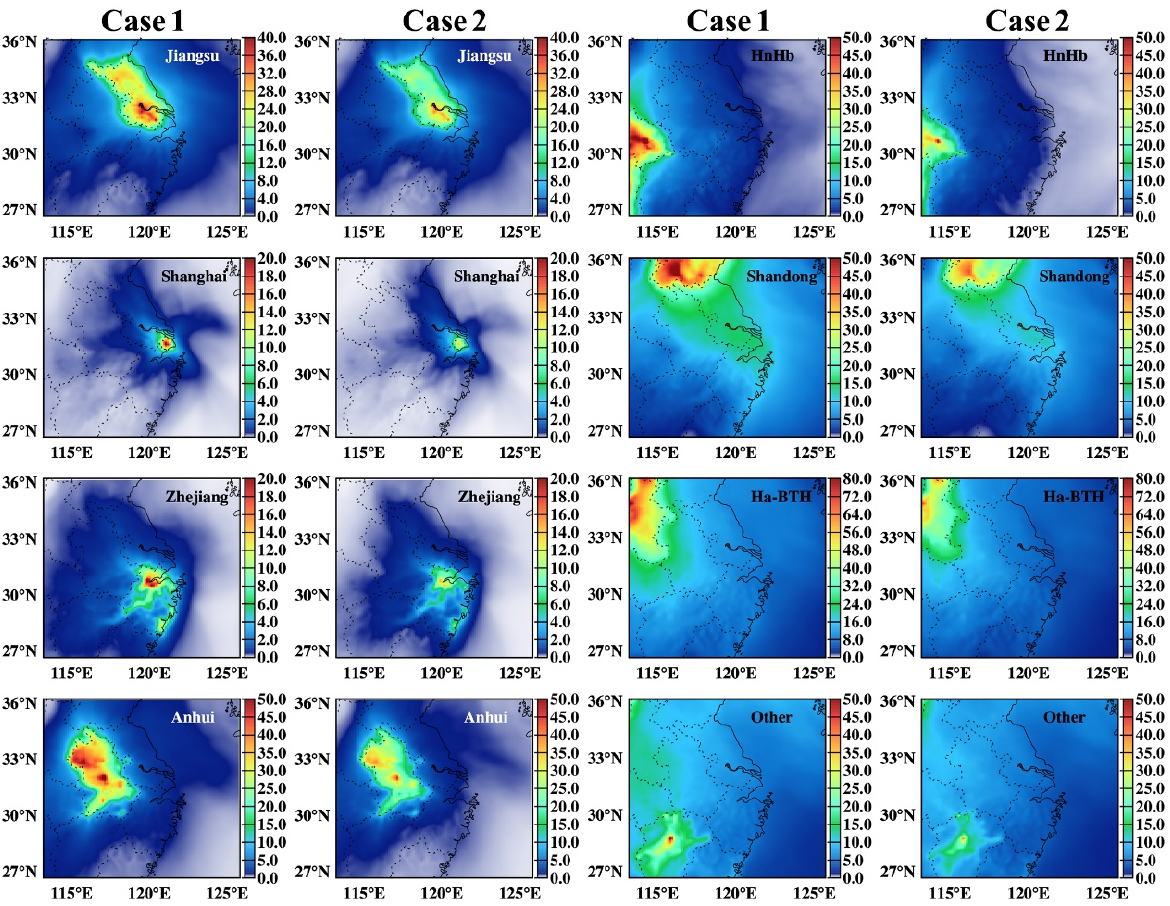
Figure 6. Averaged regional contributions of predicted PM 2 . 5 in the YRD from 23 to 28 February 2020. Note that the color ranges are different among